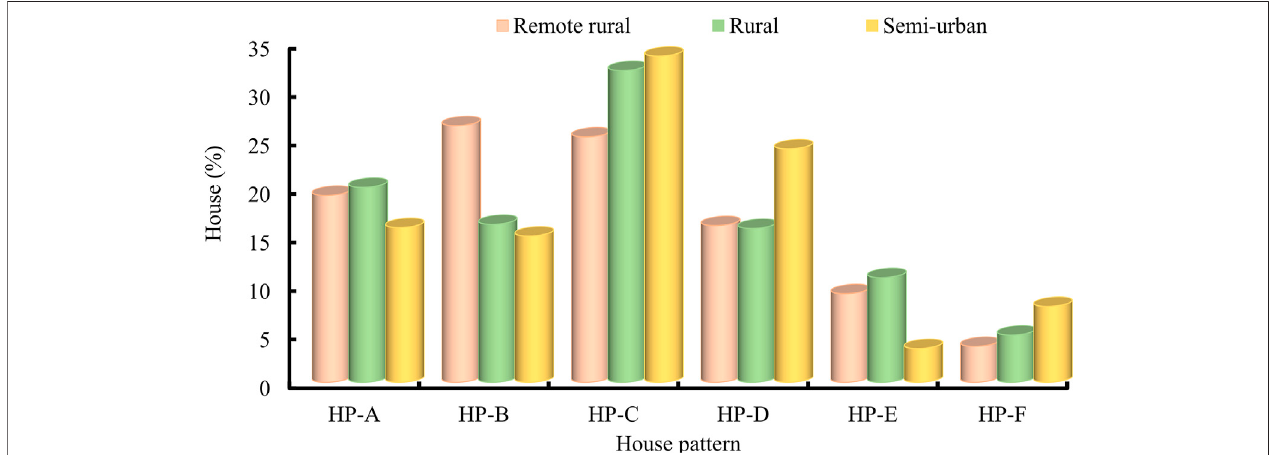
FIGURE 6 | Diagram of various green area patterns of remote rural, rural, and semi-urban areas.